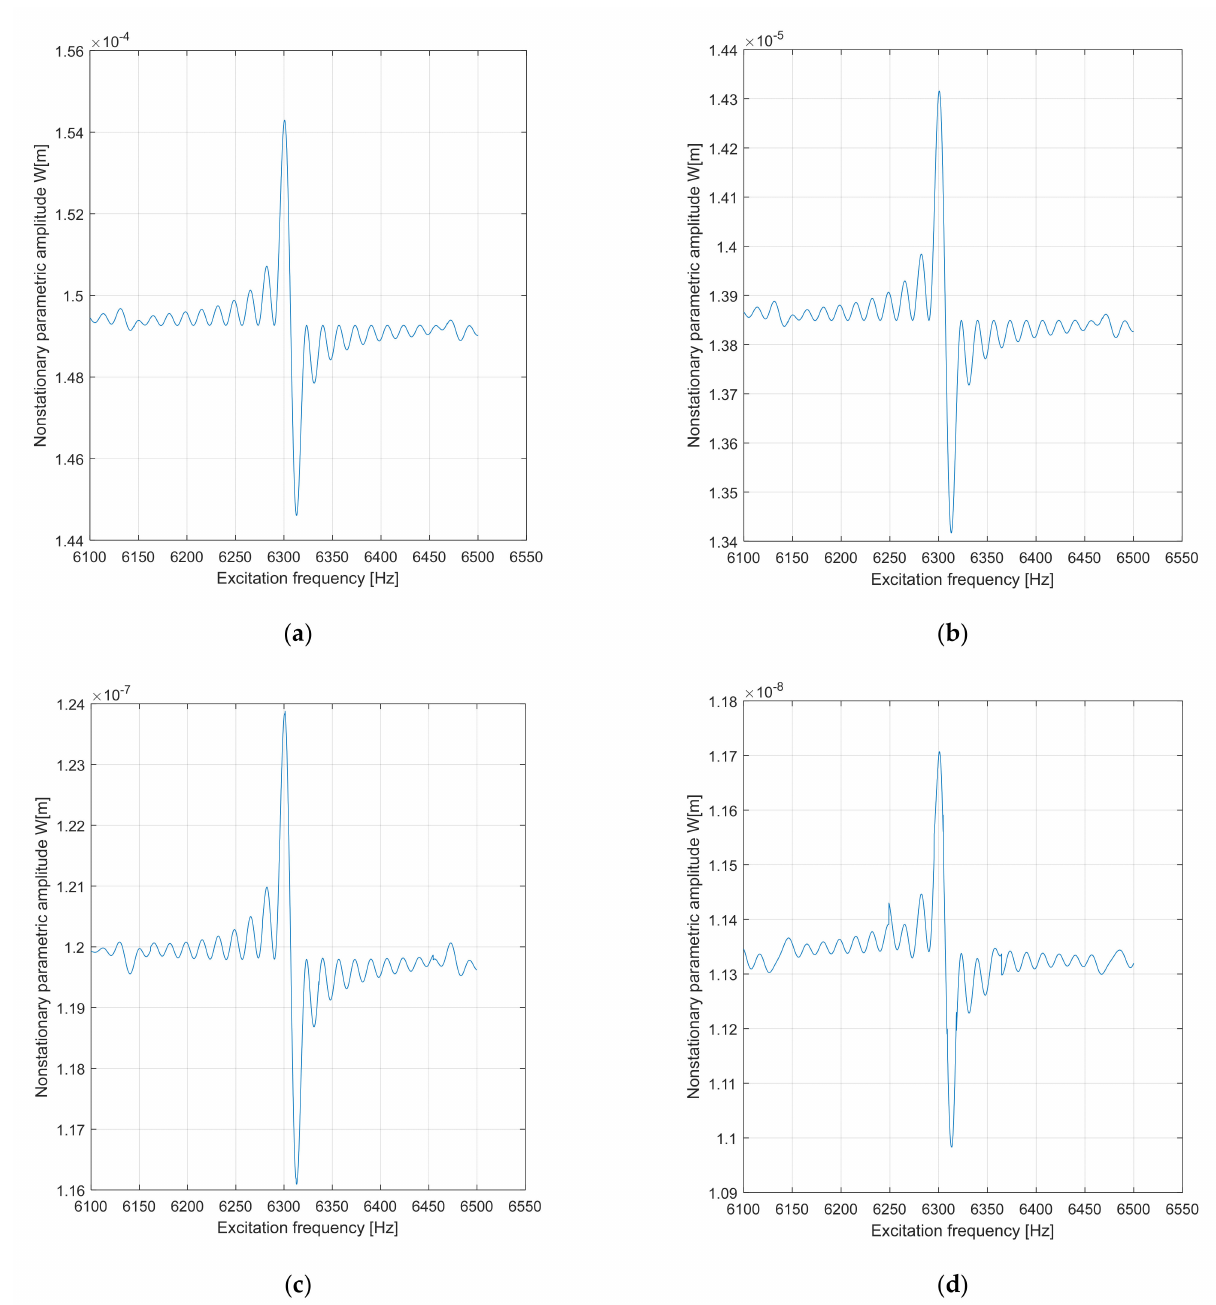
Figure 24. Nonstationary parametric amplitude spectrum W of the bowl for χ nB = 0.10, where µ = 0.754 × 10 − 4 . ( a ) ζ = 0.0016. ( b ) ζ = 0.0036. ( c ) ζ = 0.0076. ( d ) ζ = 0.0096. Here, m = 1.4 × 10 − 5